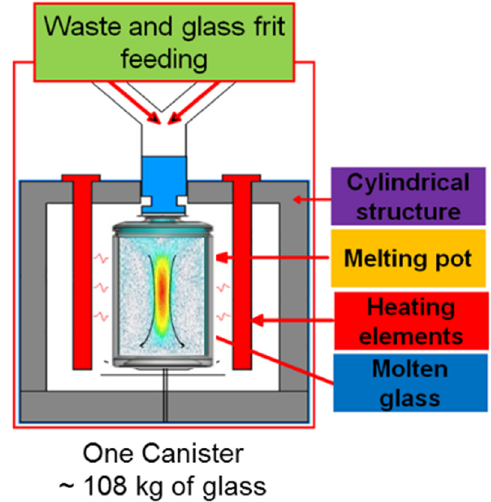
Fig. 4. Simpli fi ed diagram of the In-Can Melter